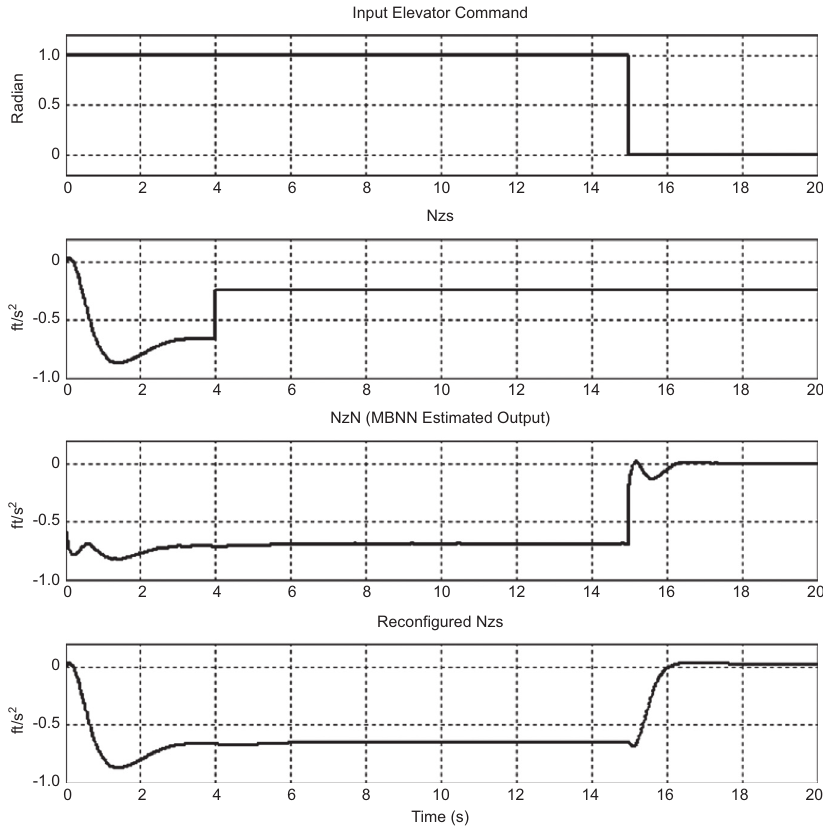
Figure 9. SFDA for Stuck Fault of “–0.25” at 4 s.